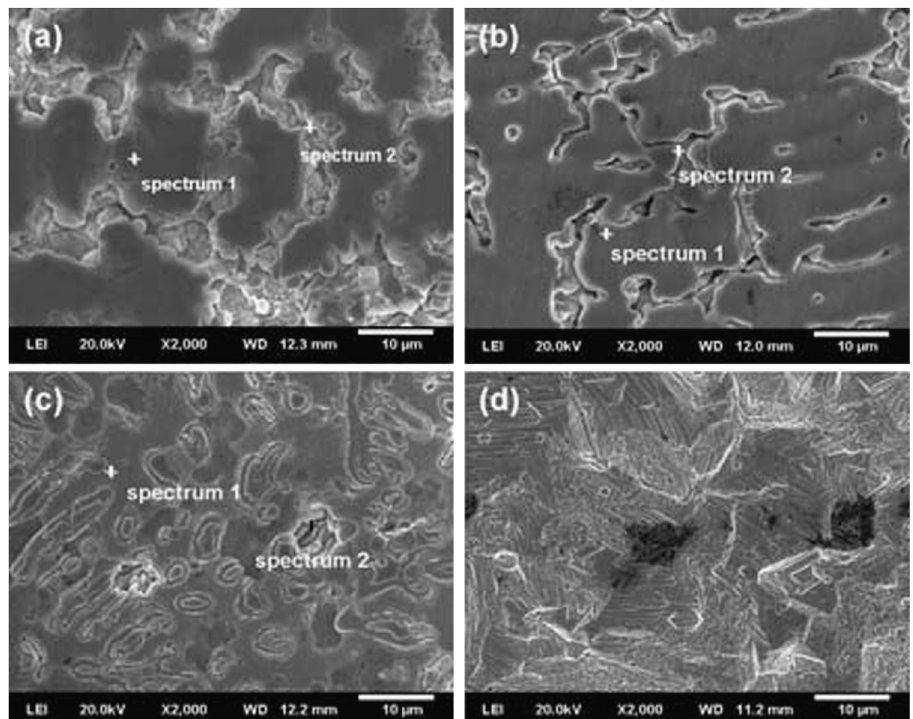
Fig. 10 Typical surface morphologies of the CuCrFeNiMn system after immersion tests in 1 M sulphuric acid for 100 h: a CuCrFeNiMn (S1), b